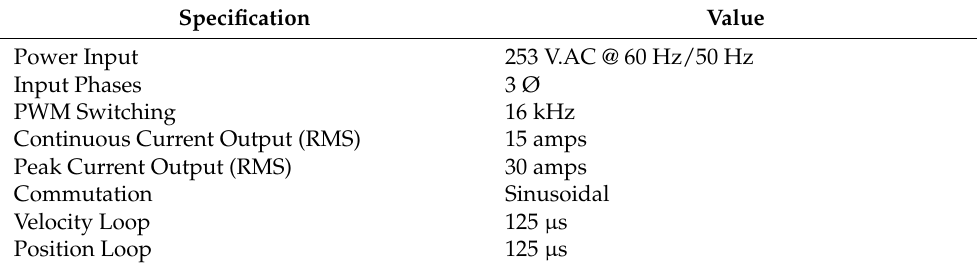
Table 2. Parker Compax3 T10 Drive Specifications (Parker Hannifin Corp. parkermotion.com, accessed on 1 May